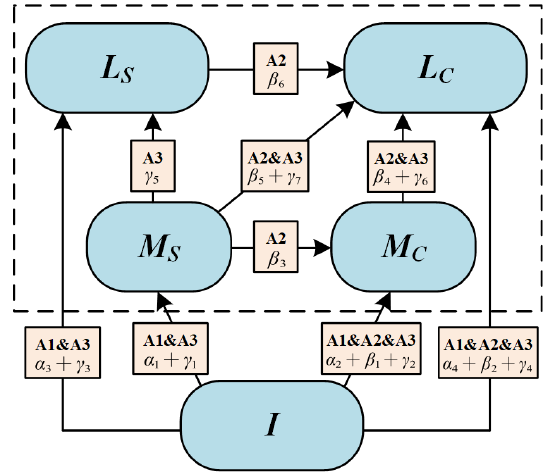
Figure 2. Online collaborative state evolutionary model.